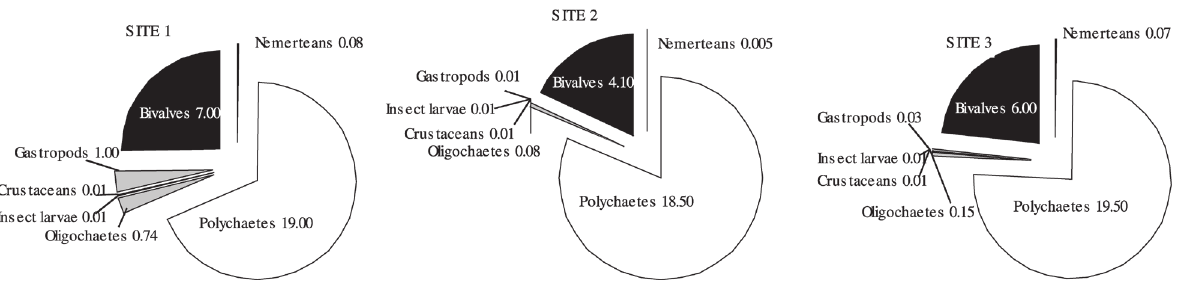
Fig . 9. – Standing stock of benthic invertebrates (in biomass, g AFDW m -2 yr -1 ), outside musselbed areas, at Culbin Sands lagoon, NE Scot- land, during 1994-1996: Arenicola marina contributed to 95% of the total polychaete stock, and Cerastoderma edule contributed to 85% of the total bivalve